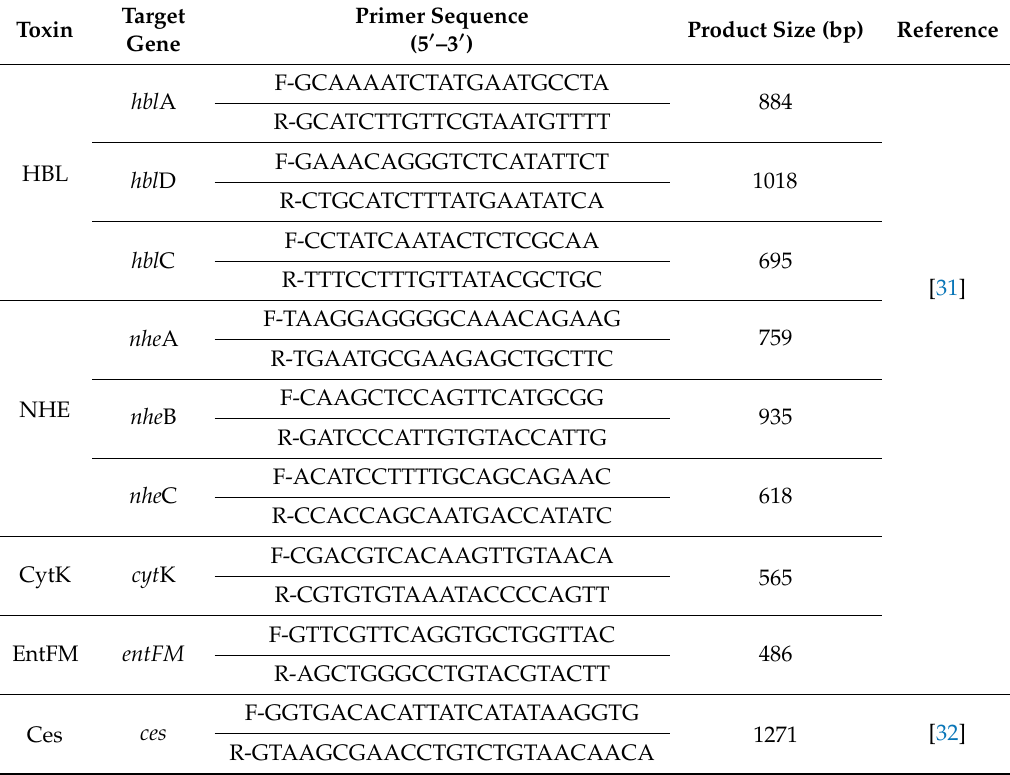
Table 1. Primer sequences utilized to detect nine genes encoding five toxins in B. cereus isolates. Target Primer Toxin Gene